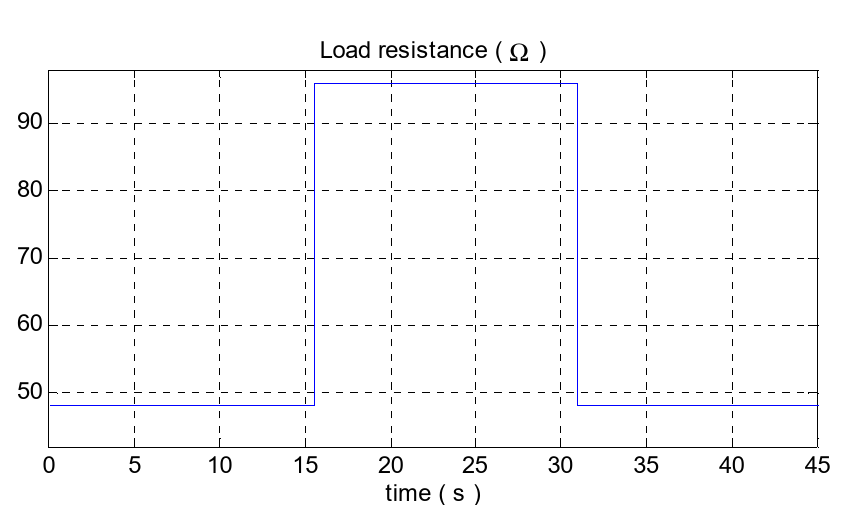
Figure 26. Duty ratio µ.